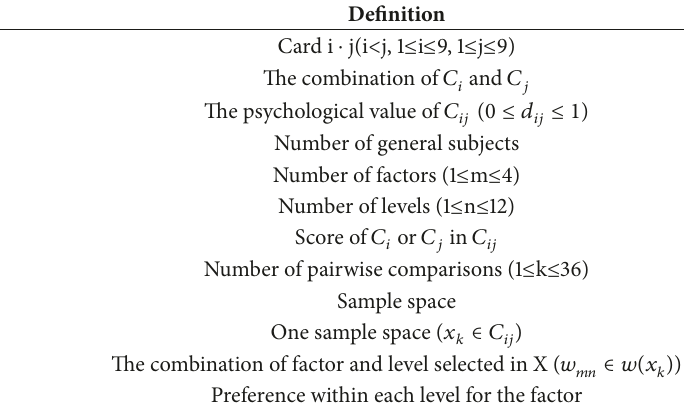
Table 4: The definitions of symbols.